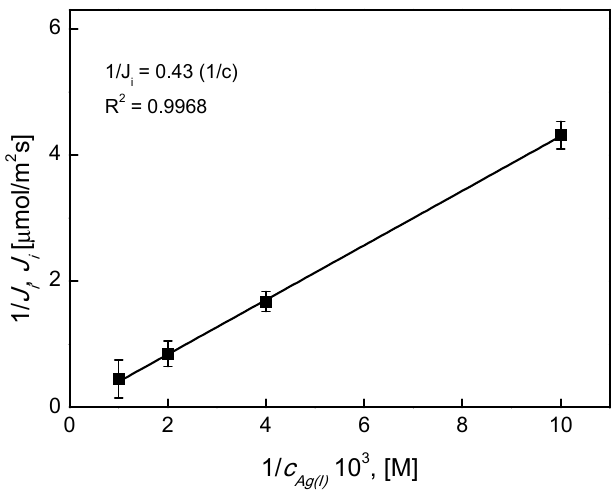
Figure 8. Relationship of 1 / J i vs. 1 / c Ag ( I ) for Ag(I) transport across a PIM containing KP. Source phase: 10 − 4 M ÷ 10 − 3 M AgNO 3 , pH = 4.0; membrane: 4.0 cm 3 o -NPPE / 1.0 g CTA; 0.050 M KP, receiving phase: 0.10 M Na 2 S 2 O 3 .